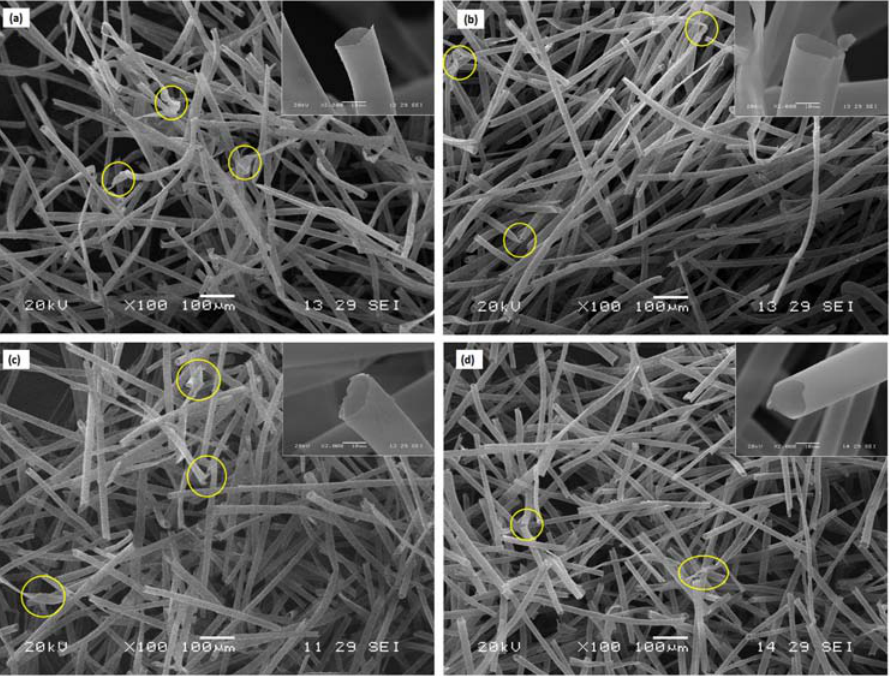
Figure 1: SEM micrographs of kapok fi bers crosslinked with BTCA at di ff erent ratios: ( a ) raw fi ber 20:1; ( b ) pretreated fi ber 20:1; ( c ) raw fi ber 5:1 and ( d ) pretreated fi ber